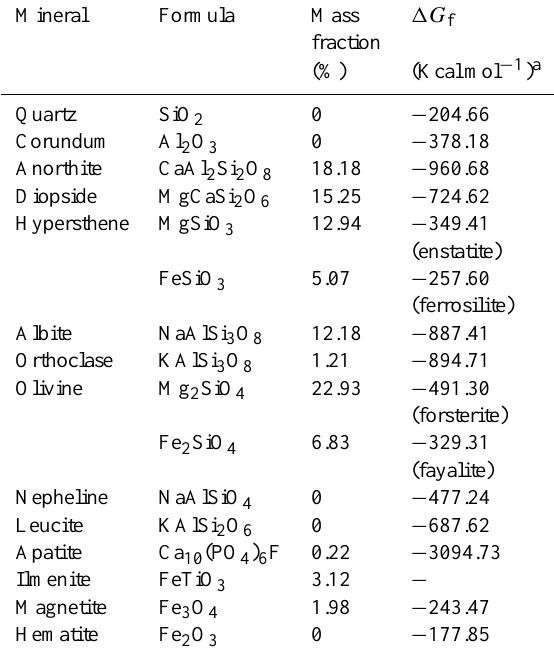
Table A1. Oxide composition of a basalt and (cid:49) G f values for the rock oxides.